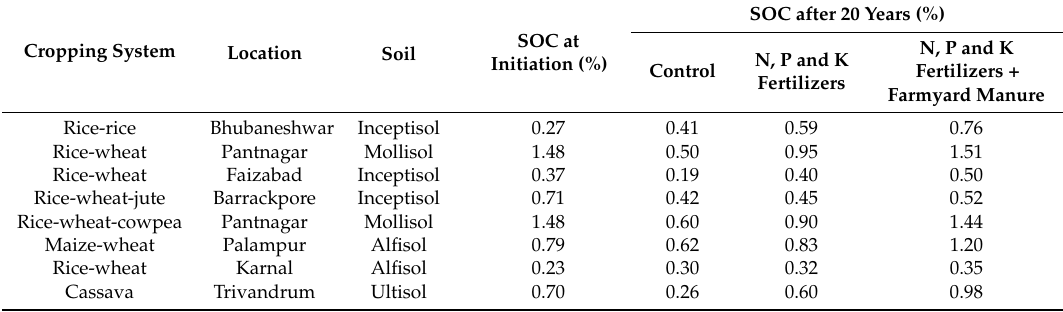
Table 6. Changes in SOC due to application of optimum N, P, and K fertilizer levels with and without farmyard manure for 20 years to different cropping systems in long-term experiments established in different soil types in